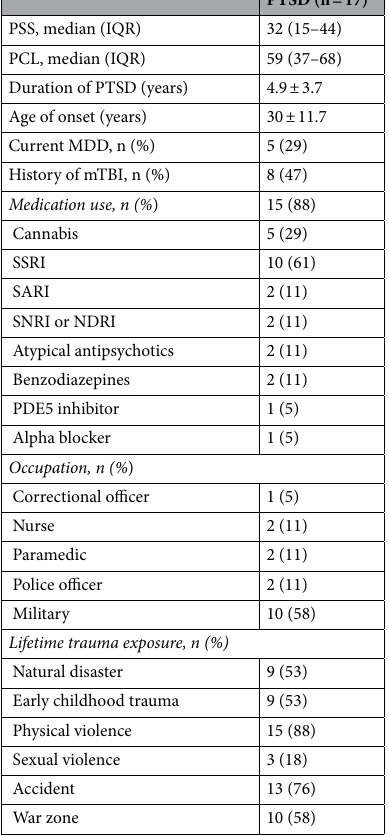
Table 2. PTSD characteristics. Values are mean ± SD unless otherwise indicated. IQR Interquartile range, MDD major depressive disorder, mTBI mild traumatic brain injury, NDRI norepinephrine-dopamine reuptake inhibitors, PDE5 phosphodiesterase type 5, PSS PTSD Symptom Scale, PCL PTSD checklist, SARI serotonin antagonist and reuptake inhibitors, SNRI serotonin-norepinephrine reuptake inhibitor, SSRI selective serotonin reuptake